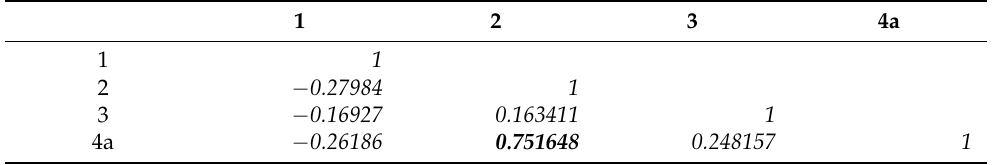
Table 2. Correlation coefficient of observed variables (1–4a).